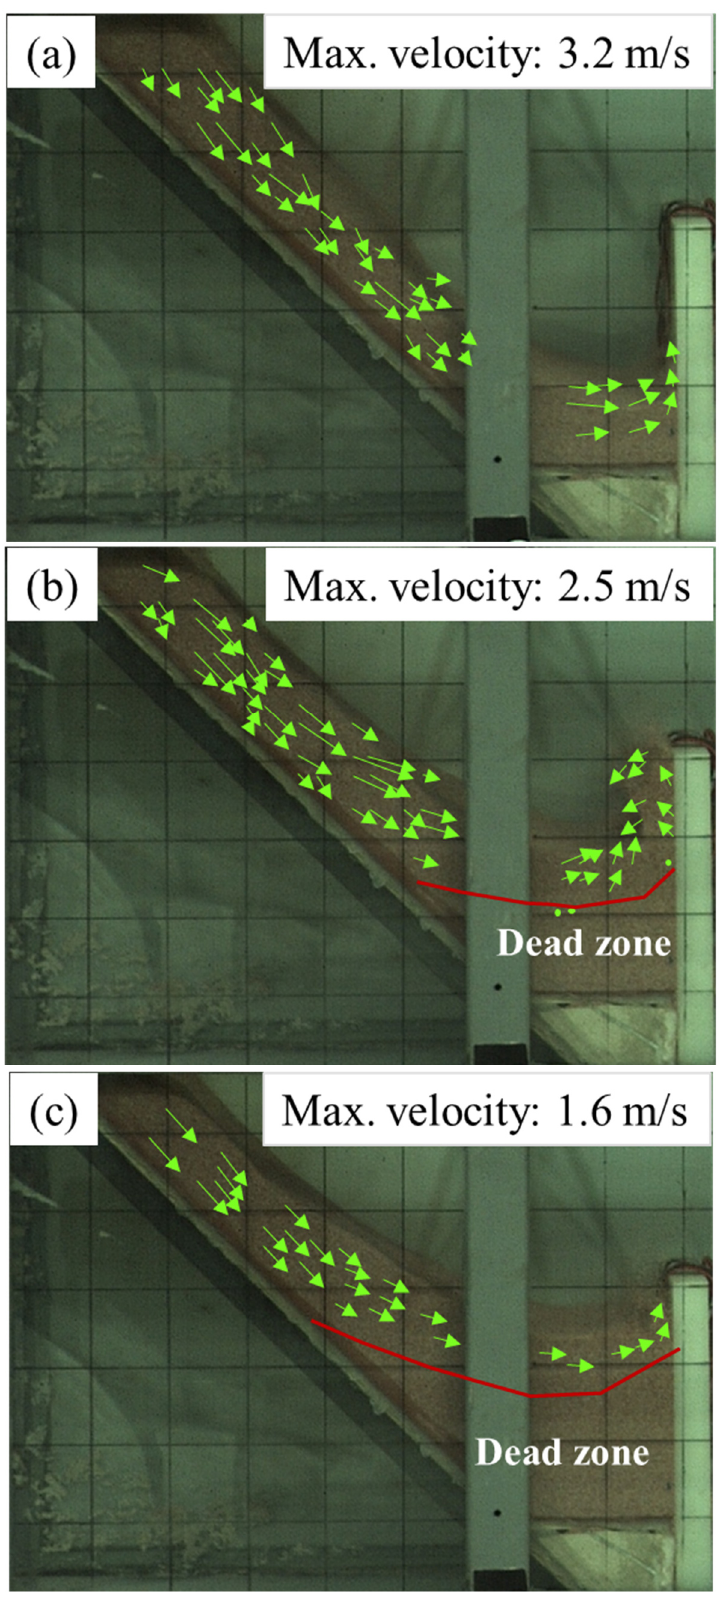
Figure 4. Velocity field of flows at different times obtained from PIV (test ID: S_10): ( a ) t = 0.00 s; and ( b ) t = 0.11 s; ( c ) t = 0.50 s.